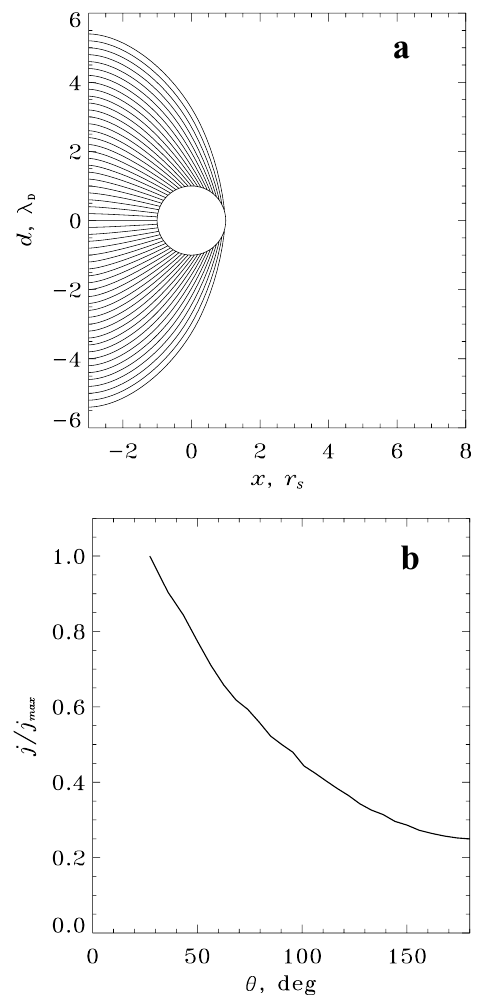
Fig. 8. (a) Trajectories of O + ions in a cold beam model with ve- locity equal to 6.2 · 10 3 ms − 1 in the field of the negatively polarised sphere with ϕ = − 4V; (b) corresponding current angular distribu- tion, θ is the angle between the velocity vector and the outward normal to the probe surface.